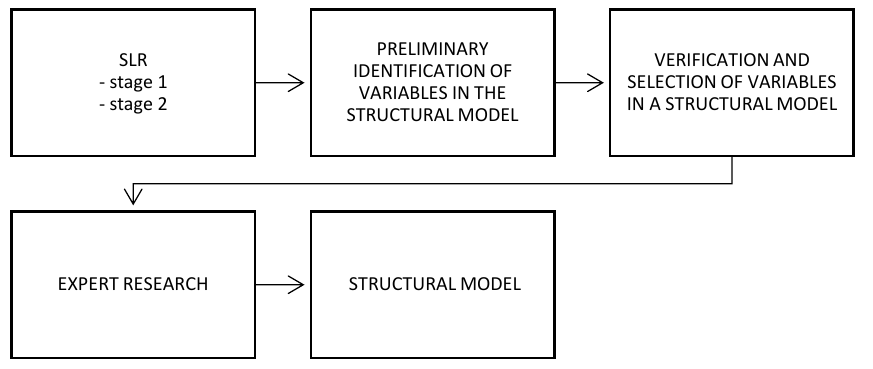
Figure 1. Scheme of the research process.